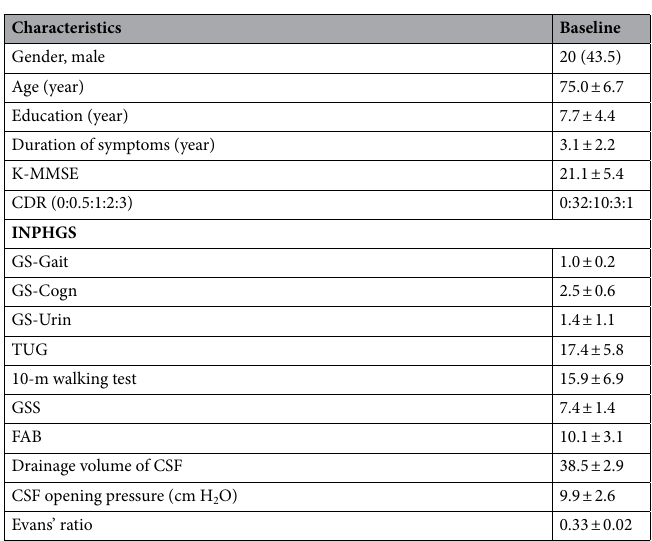
Table 1. Demographic data and clinical characteristics of INPH patients at baseline. Data were collected before the CSFTT. Values denote number (%) or mean ± standard deviation. INPH, idiopathic normal